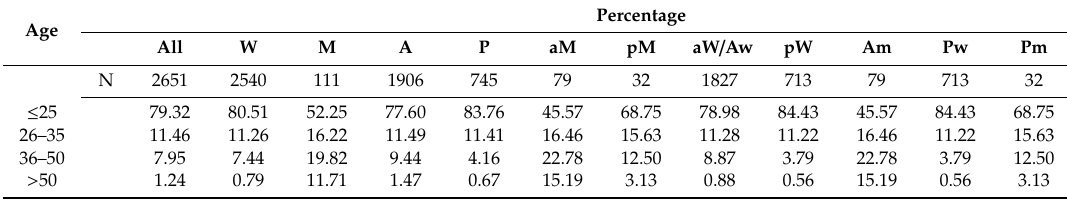
Table 1. The percentage age distribution for groups of